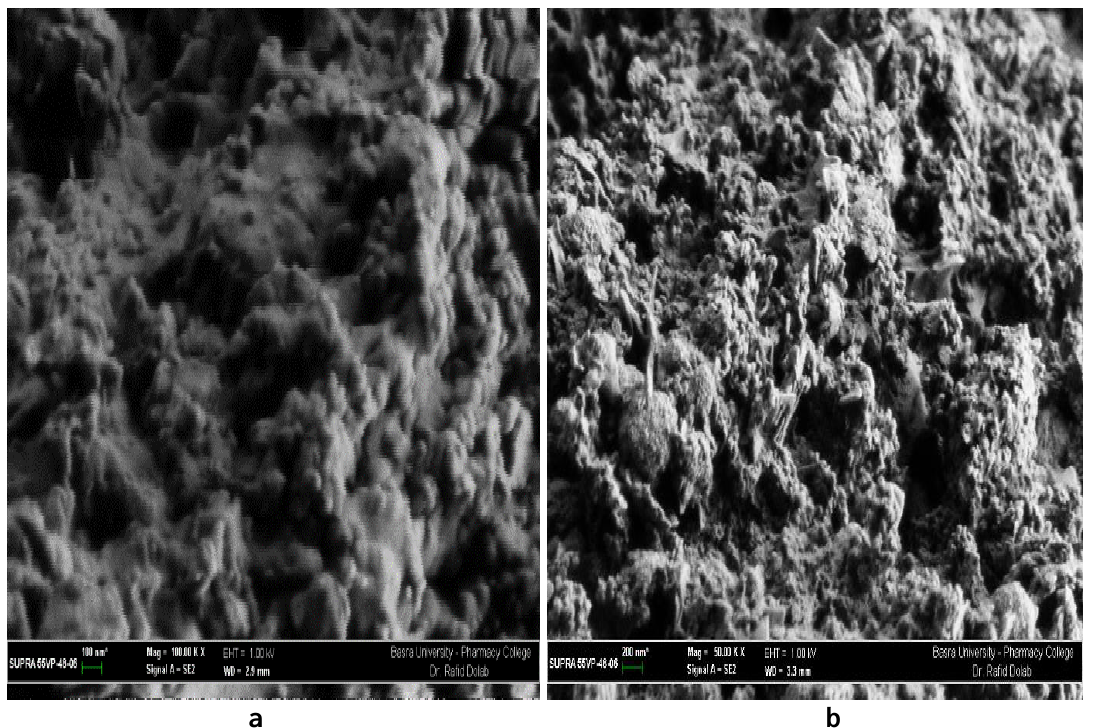
Figure 6. SEM image for ZnONPs synthesized by PPE. a)100 nm, b) 200